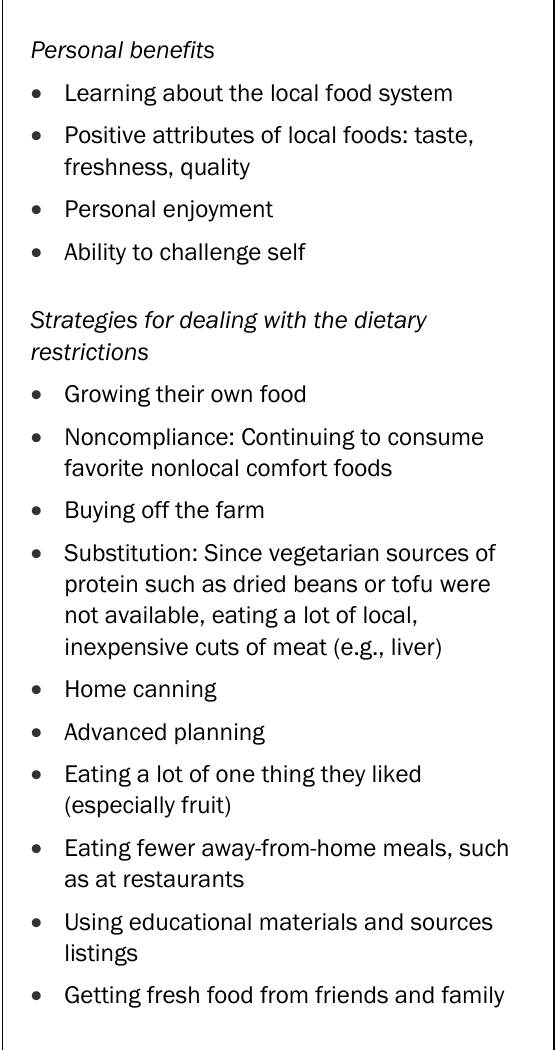
Figure 1. Summary of key themes that emerged from the focus groups, including benefits, challenges, and coping strategies reported to assist in dealing with the restrictions of the 100-mile